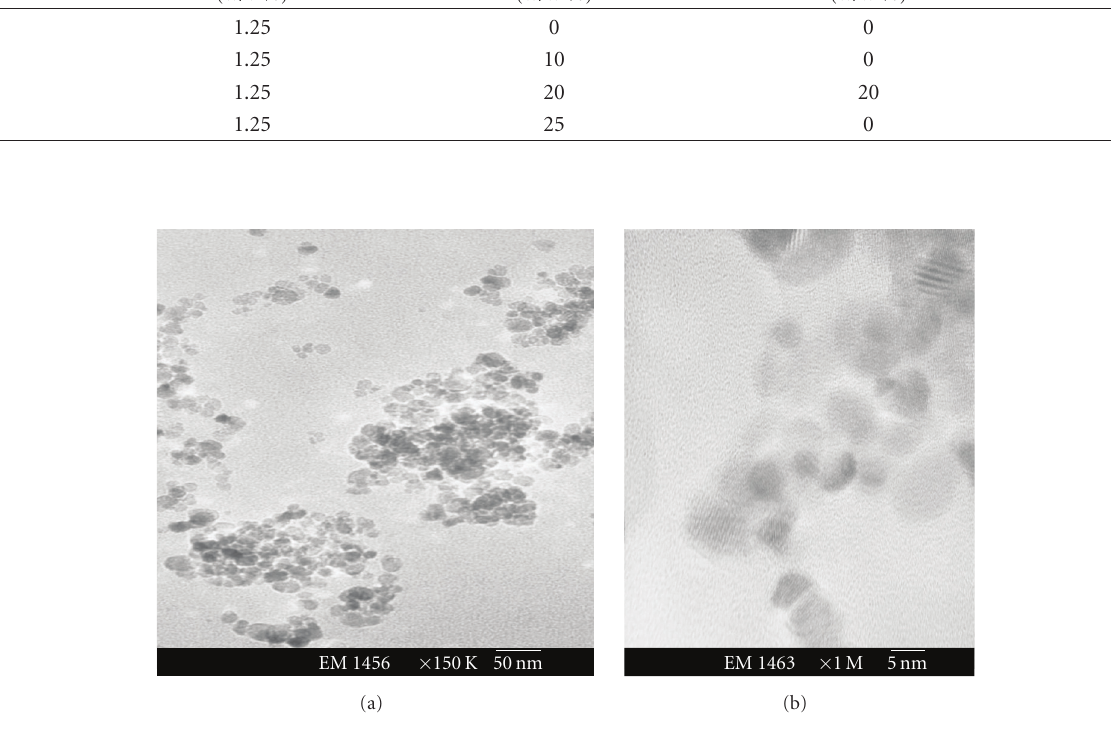
Figure 5: TEM images of drug-carrying nanocomposite spheres showing the distribution of magnetite nanoparticles in PLGA matrix at low (a) and high (b) magnifications.